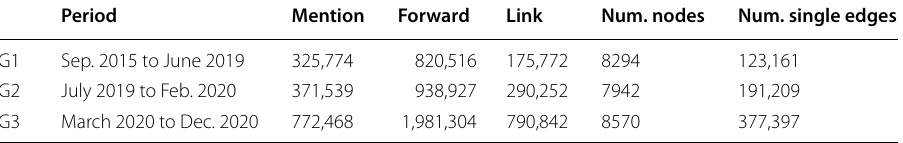
We report the numbers for the three types of interactions between channels: mention of another channel, forwarding a message from another channel and posting a link to another channel. We also report the number of single edges, i.e. the number of directed edges between channels discarding parallel edges between the two same channels